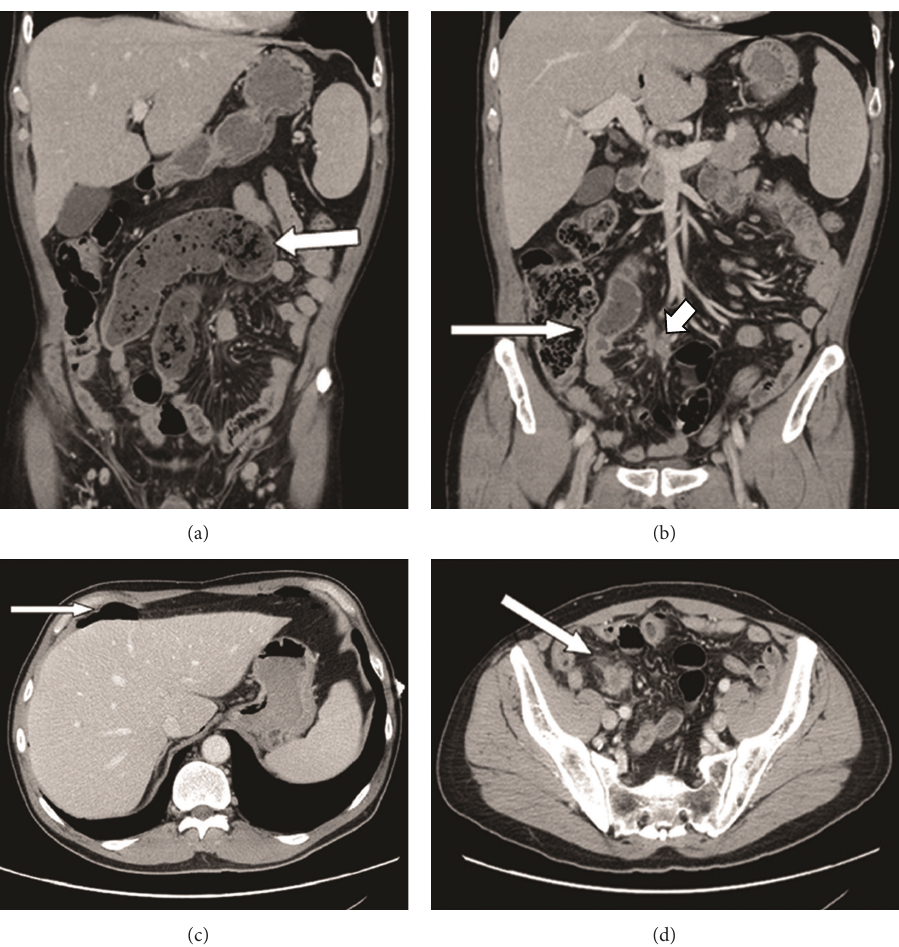
Figure 1: (a) Coronal contrast-enhanced CT image shows a markedly dilated fluid filled small bowel loop in the mid to right abdomen ( arrow ). There is evidence of stasis with small bowel fecalization sign. (b) Coronal contrast-enhanced CT image shows point of transition with associated irregularity and thickening of the bowel wall ( large arrow ). Note the abnormal enhancing lymph node ( small arrow ) in the adjacent small bowel mesentery (medially). (c) Axial contrast-enhanced CT image shows free intraperitoneal air below the ventral abdominal wall ( arrow ) in keeping with perforation. (d) Axial contrast-enhanced CT image shows a necrotic enhancing lymph node in the right lower quadrant ( arrow